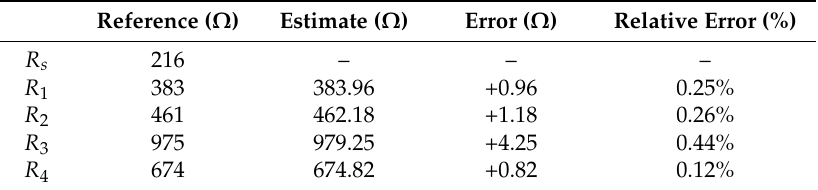
Figure 7. Measurement of the voltage drop U 1 across the sense resistor for determination of current flow through electrode n ◦ 1, in the frequency domain. Table 2. Determination of resistors: experimental estimates, reference measurements with Ohmmeter, and